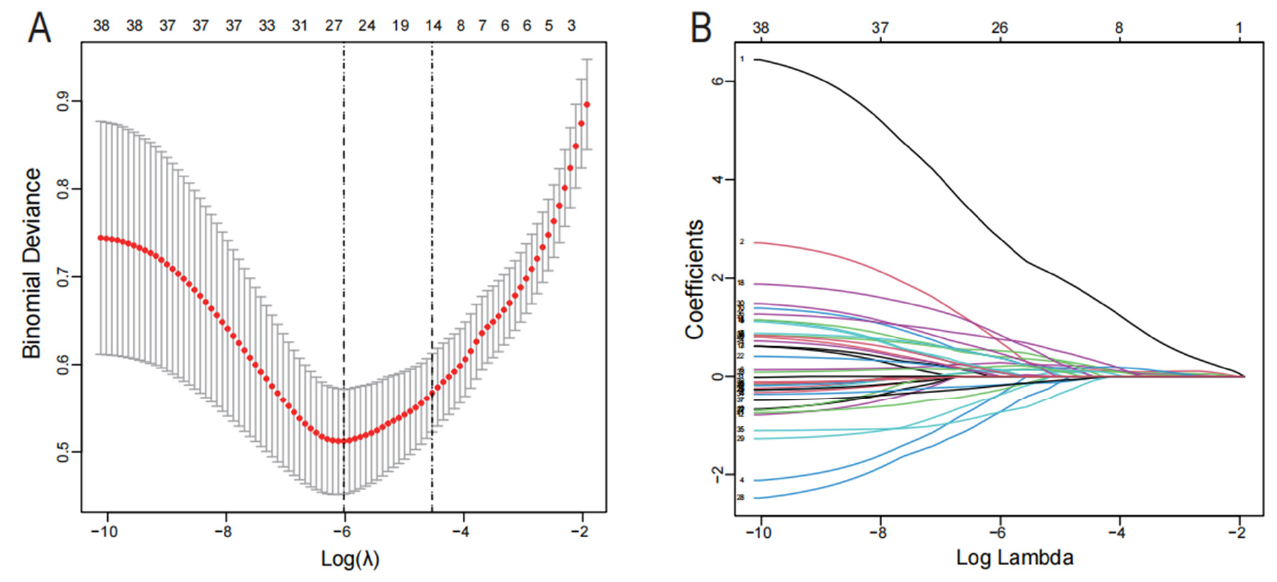
Figure 2. Screening of diagnostic markers via the Lasso regression. ( A ) Lasso coefficient distribution misclassification error. ( B ) Different colors correspond to various genes in the distribution of Lasso coefficients for 38 related genes. Table 2. Generalized linear model screening results.